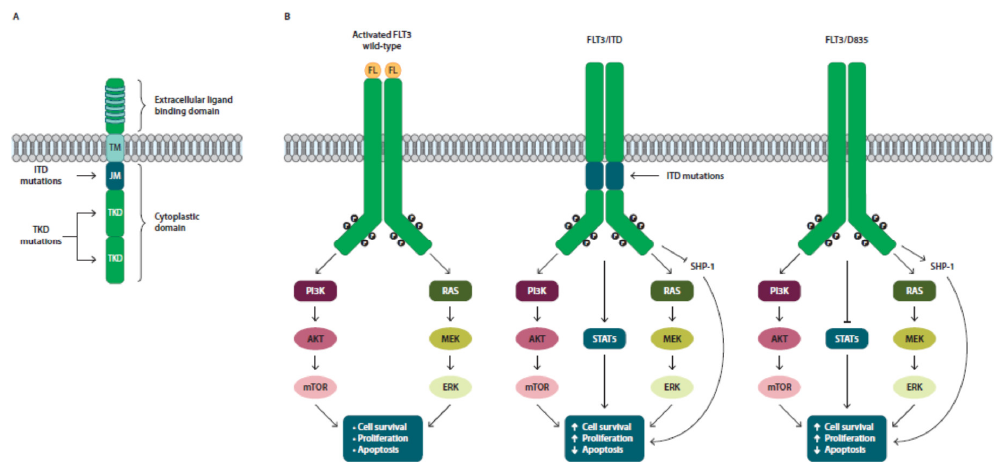
Figure 2. Structure and signaling pathways of activated and mutated FMS-like tyrosine kinase 3 (FLT3). ( A ) Schematic representation of inactivated FLT3; ( B ) Ligand binding to the wild-type FLT3 receptor activates several signaling pathways, such as PI3K/Akt/mTOR and RAS/ mitogen-activated protein kinase kinase (MEK)/extracellular-signal-regulated kinase (ERK), pathways, which are involved in cell survival, proliferation, and apoptosis; FLT3/ITD and FLT3/TKD constitutively stimulate RAS and PI3K downstream pathways, but FLT3/ITD activates STAT5 signaling and reduces the expression of SHP-1, while the mutant form FLT3-D835 activates SHP-1 phosphatase and negatively regulates STAT5 signaling. P: phosphorylation site; TM: transmembrane domain; JM: juxtamembrane domain; TKD: tyrosine kinase domain; ITD: internal tandem duplications; FL: FLT3